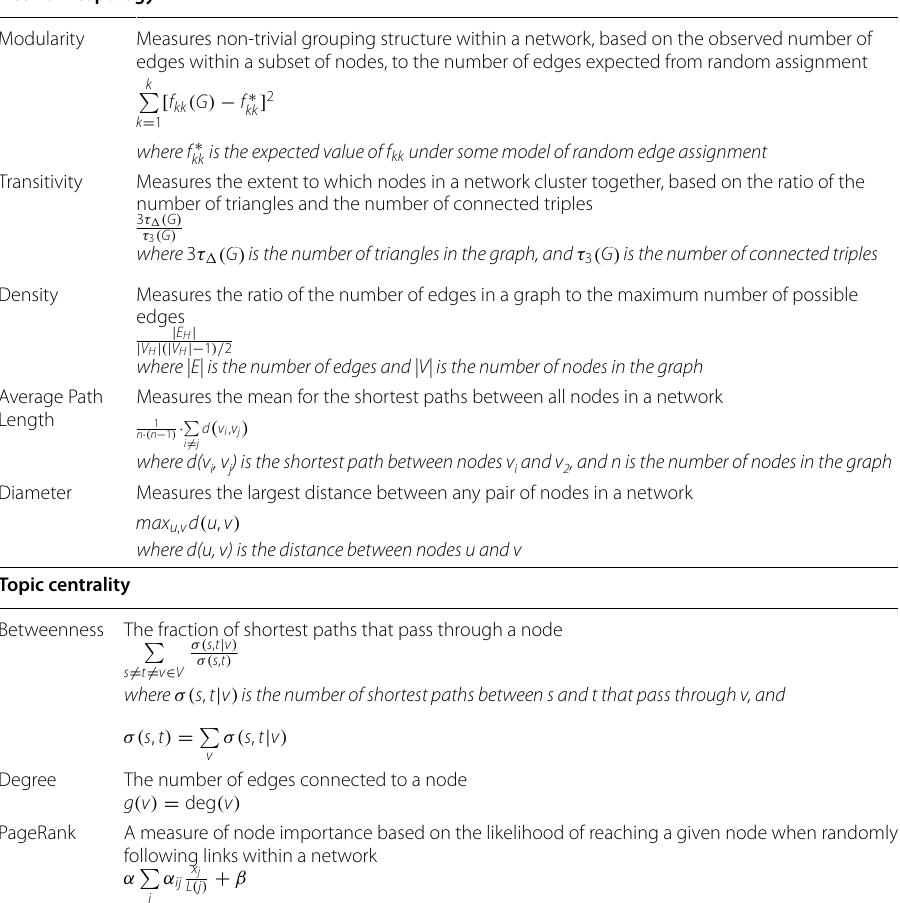
Table 1 Network topology and topic centrality metrics [42–45] Network topology